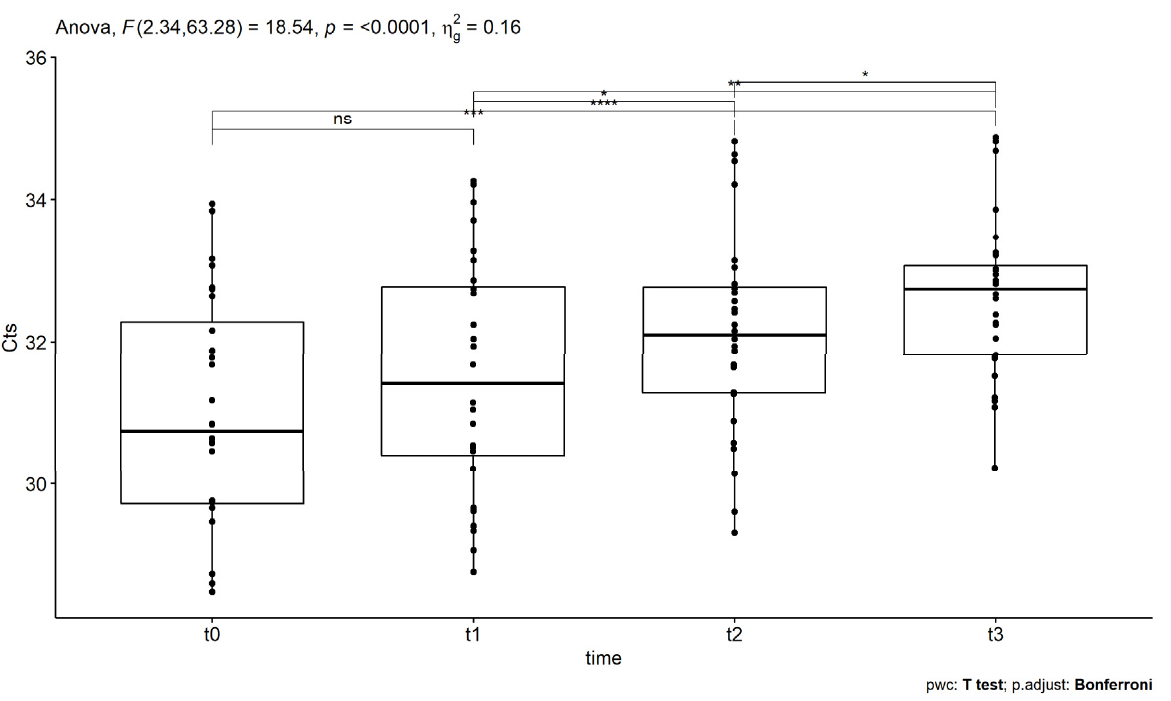
Figure 3. The boxplots of Ct measurements for the HSV virus at the different time points t0 (before the first SOT administration), t1 (after the first treatment administration), t2 (after the second treatment administration), and t3 (after the third treatment administration). The asterisks denote significance codes, namely ‘****’ stands for p -value < 0.0001, ‘***’ stands for p -value < 0.001, ‘**’ stands for p -value < 0.01, ‘*’ stands for p -value < 0.05, and ‘ns’ stands for non-significant, after Bonferroni correction. Increases, after the second and third SOT administrations, were found to be statistically